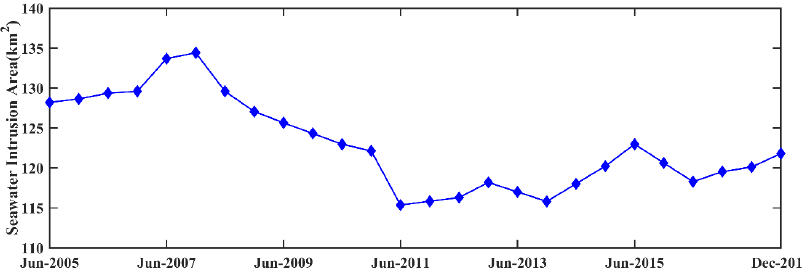
Figure 2. Changes of monthly average groundwater level (GWL) in three zones (years 2000–2017). Figure 3. Changes of six-monthly seawater intrusion area (SIA) in the study area (years 2005–2017).